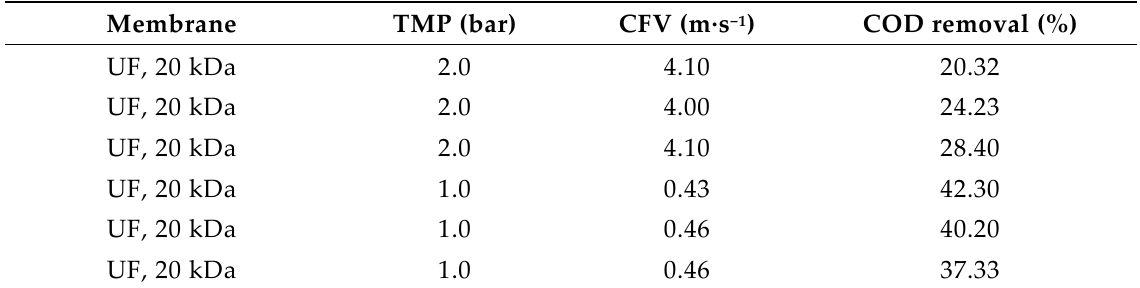
Table 6. Representative performance reproducibility data for 20-kDa ceramic